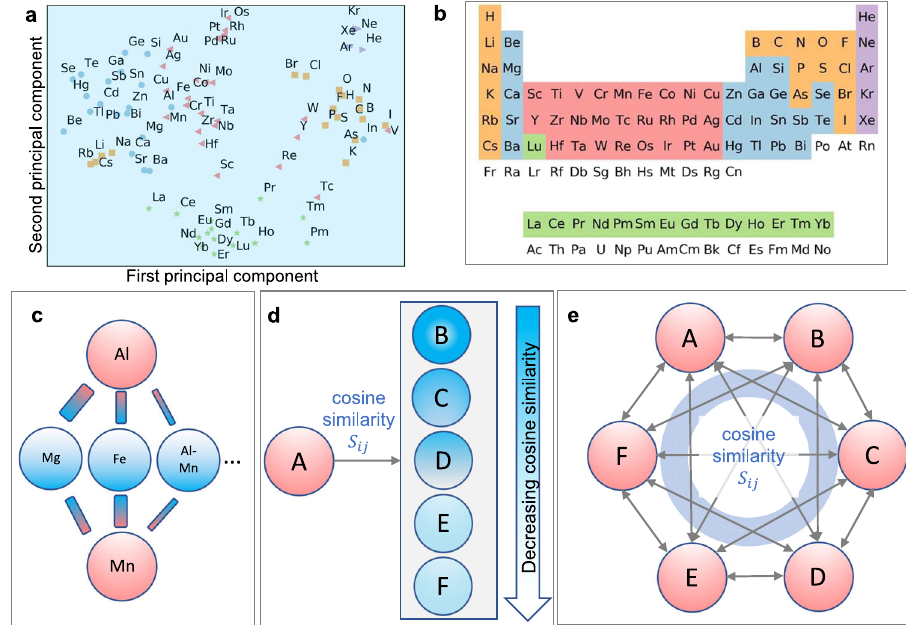
Fig. 2 | The context-similar elements and their applications to design high- entropy alloys. a Chemical elements in the latent space by the principal compo- nent analysis (PCA) based on their word vectors. The horizontal and vertical axes are the fi rst two components of PCA. The elements are colored according to the scheme shown in the Periodic Table of Elements ( b ). c We explain the reasons for the difference between Mendeleev ’ s PTE and the chemical elements in the latent space by taking elements Al and Mn as examples. The thicknesses of the sticks